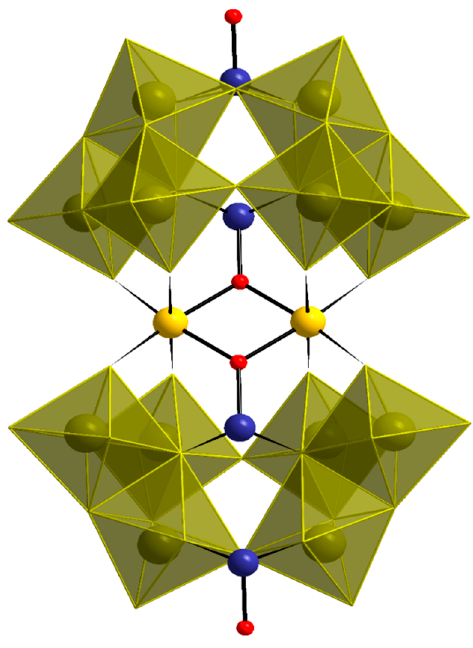
Figure 1. Combined polyhedral/ball-and-stick representation of 1 . Color code: WO 6 octahedra olive green, As blue, Fe yellow, O red.